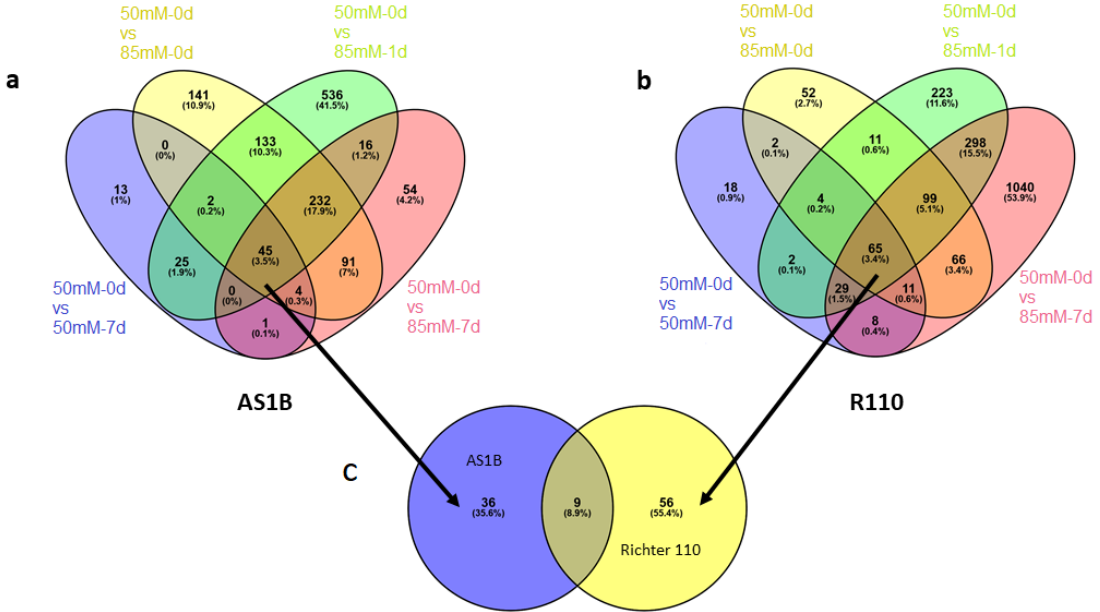
Figure 5. Venn diagram representation of DEGs under different salinity conditions (from 50 mM- 0 d vs. 50 mM-7 d to 50 mM-0 d vs. 85 mM-7 d) for AS1B ( a ) and Richter 110 ( b ). Number of overlapped and non-overlapped areas that represent DEGs through the different conditions of salinity stress, with their equivalent percentages from the total amount of DEGs retrieved by consensus between NOISeq and DESeq2 pipelines. ( c ) Venn diagram representation of genes showing continuous differential expression across all conditions. Overall, 36 unique DEGs from AS1B, 56 DEGs from Richter 110, and 9 DEGs shared in common between genotypes (in total, 45 and 65, respectively, as seen in the core areas of ( a , b )), with their equivalent percentages from the total combined amount of DEGs between genotypes.